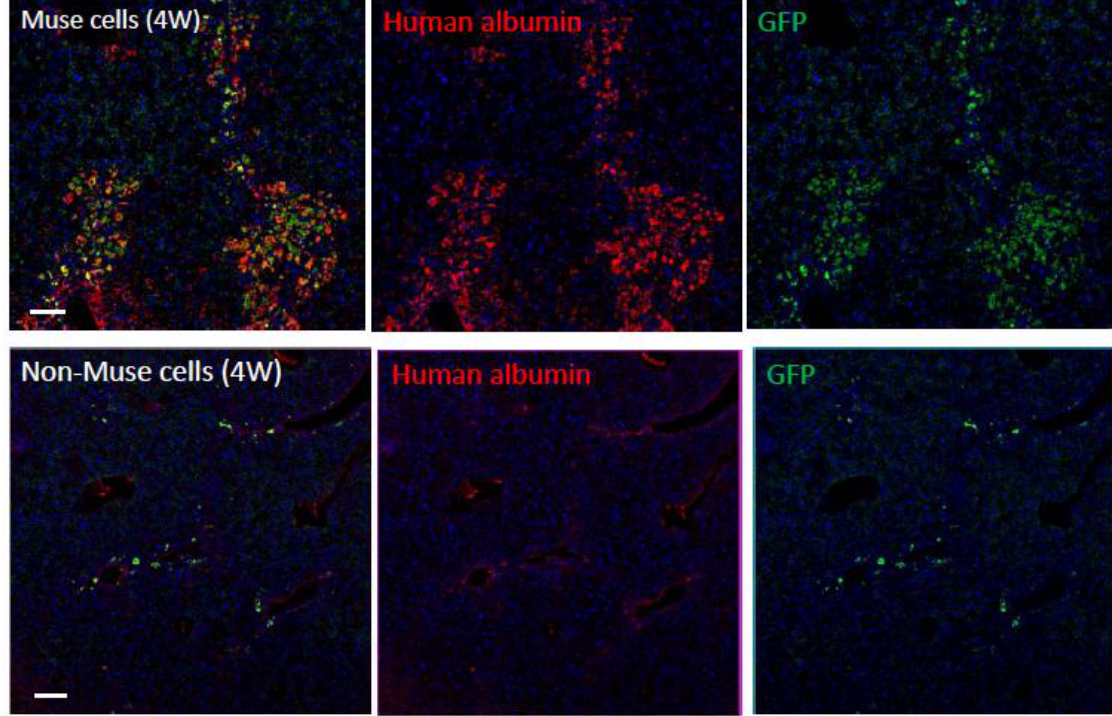
Figure 6. Differentiation and repair effects of Muse